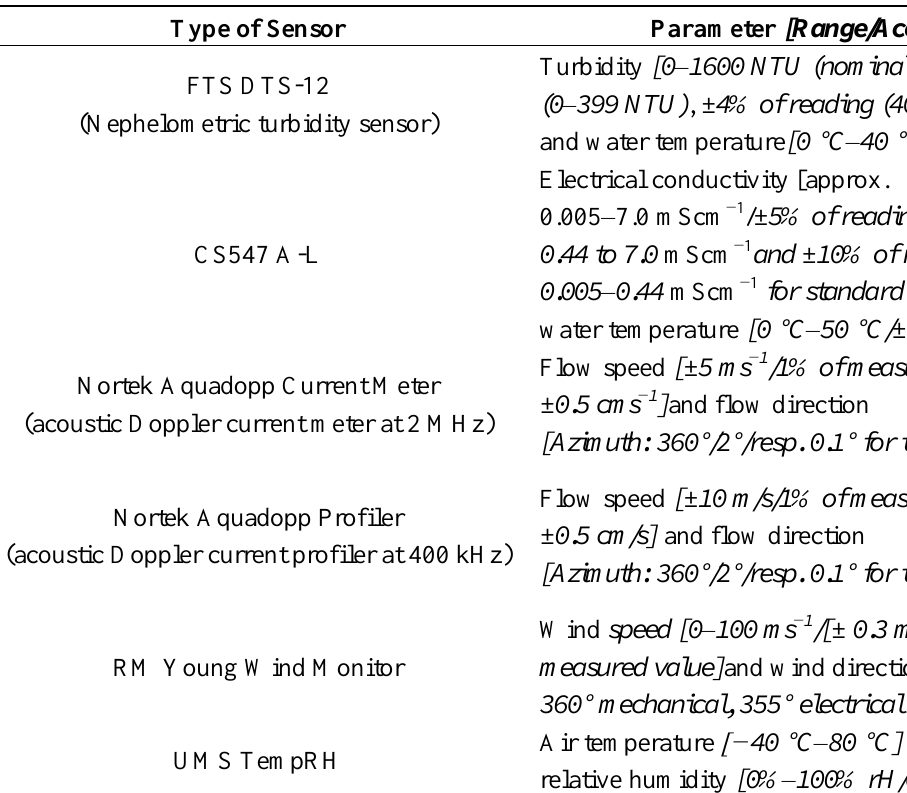
Table 2. Allocation and technical overview of sensors attached to buoy during test operation. Logging interval for all sensors is ∂t = 15